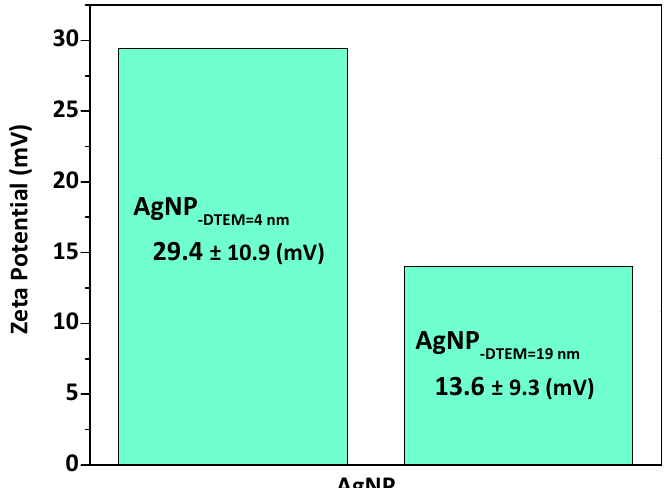
Figure 4. Zeta potential characterization of PEI-coated, PVP-stabilized AgNP performed in aqueous solution at neutral pH.